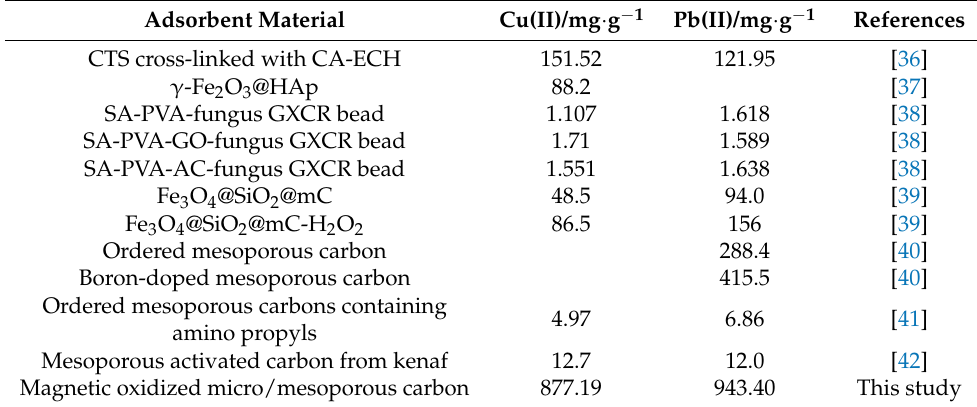
Table 6. Comparison of adsorption